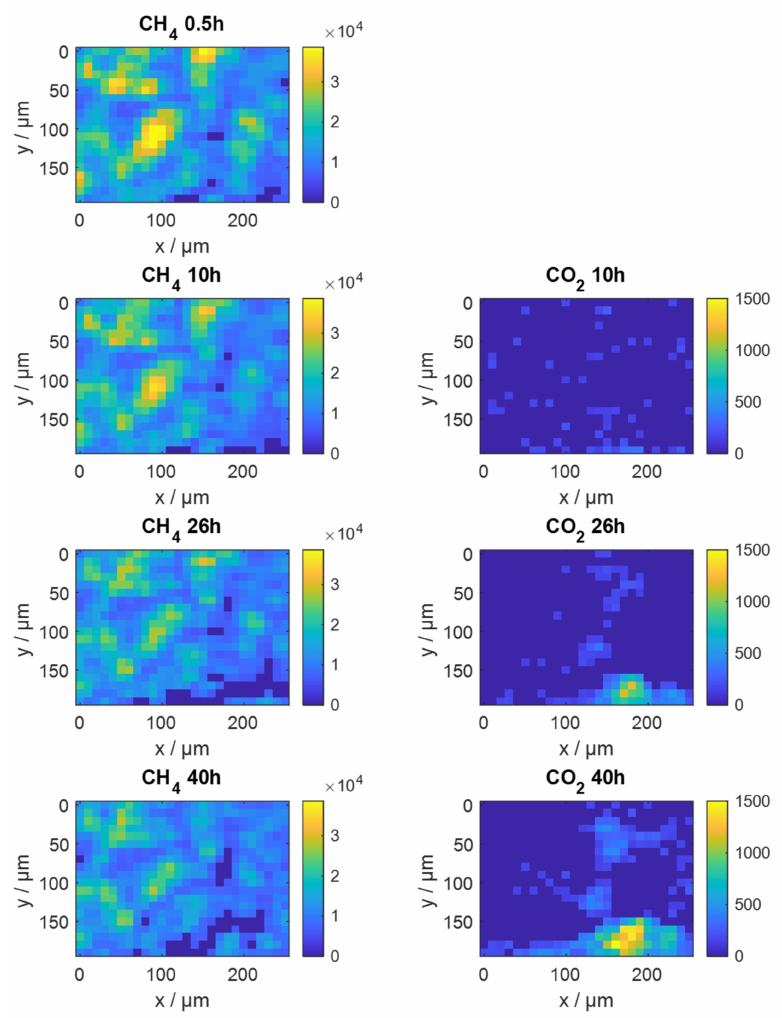
Figure 9. CH 4 and CO 2 hydrate maps of experiment NoFlowI2 at times 0.5 h (only CH 4 hydrate), 10 h, 26 h, and 40